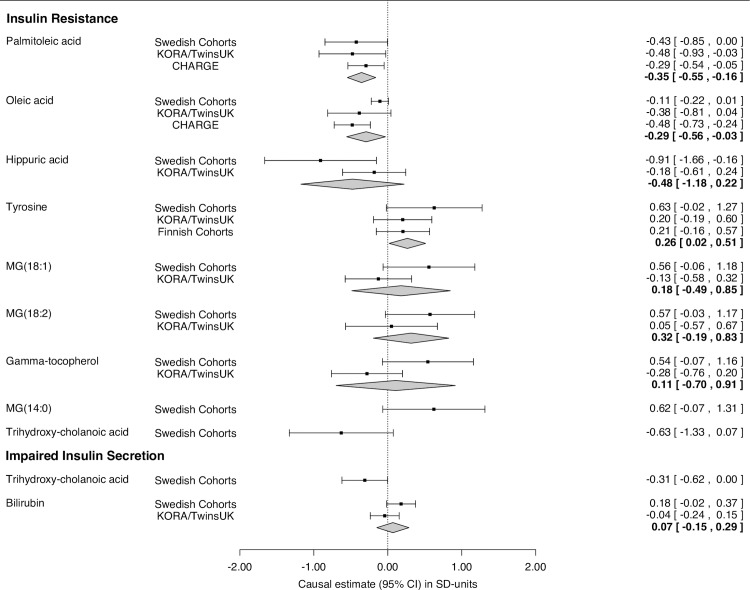
Causal estimates (95% CI) for IR and impaired insulin secretion on metabolite levels.Estimates (p < 0.1) in the Swedish cohorts (PIVUS and TwinGene, n = 2,613) and the replication studies (nKORA = 7,824, nCHARGE = 8,961, nFinnish = 8,330) are expressed as SD-unit change in metabolite levels associated with a 1 SD increase in genetically determined IR (reduced clamp M/I) or impaired insulin secretion (reduced IGI30).